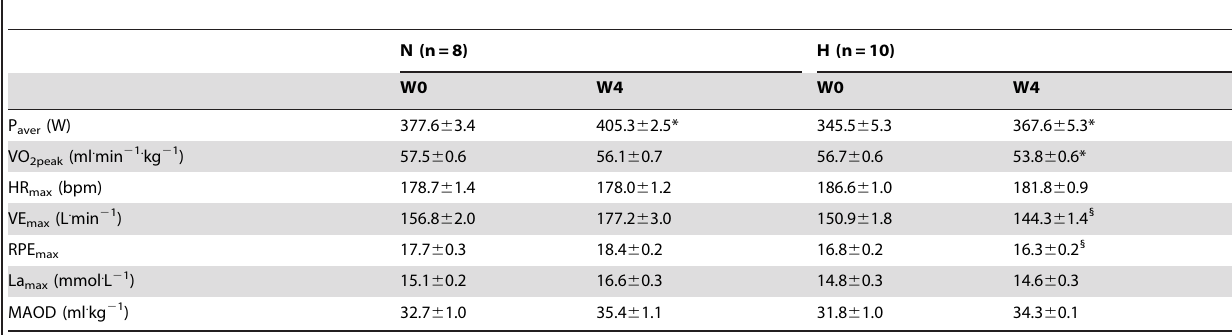
Table 5. Mean ( 6 SE) values of the 2-min all-out exercise of Normoxic (N; n= 8) and Hypoxic (H; n =10) groups.